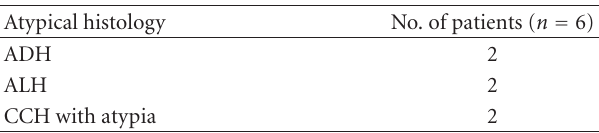
Table 3: Histologic findings of MRI-guided needle core biopsies that showed